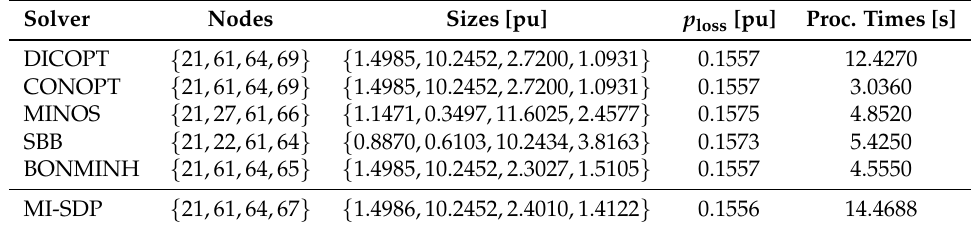
Table 5. Comparison of the MI-SDP with the MINLP model solved in GAMS for the 69-node test feeder with four distributed